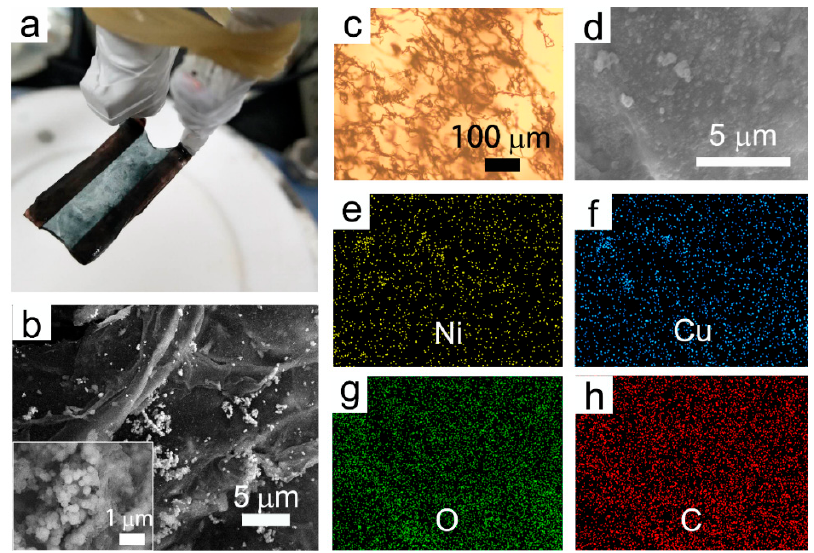
Figure 4. ( a ) Photograph, ( b ) SEM image, ( c ) optical microscopic image, and ( d ) zoomed SEM and the corresponding EDX mapping images ( e – h ) of freestanding hydrogel film deposited on the Cu electrodes (inset in ( b ) is the zoomed SEM image).